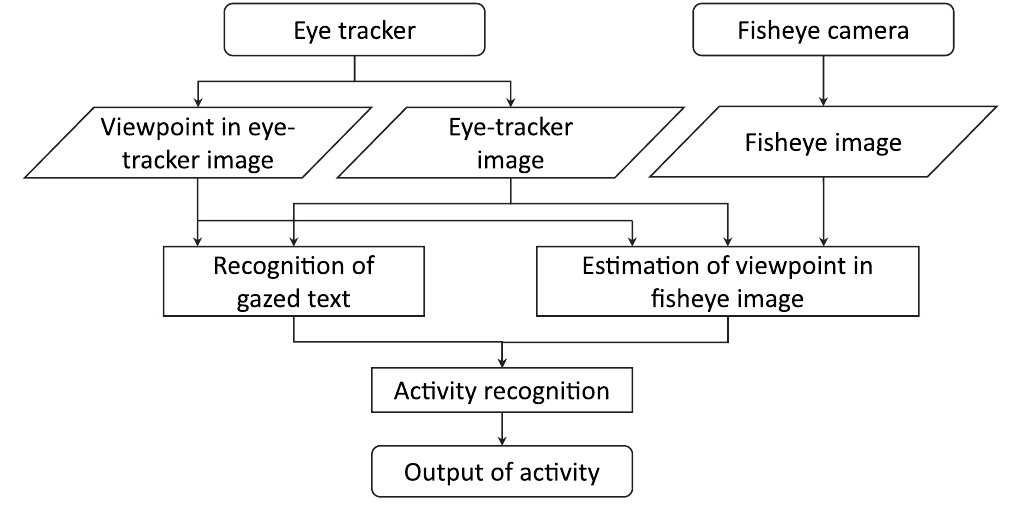
Figure 1. Outline of the proposed